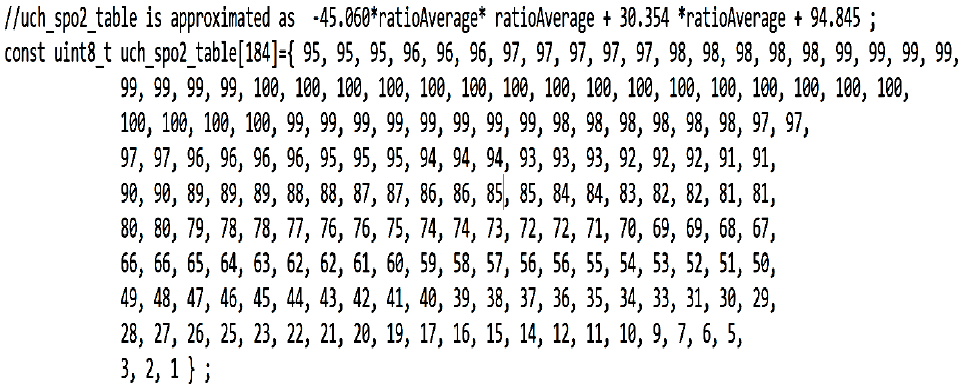
Figure 15. Array used for the SpO 2 calculation.